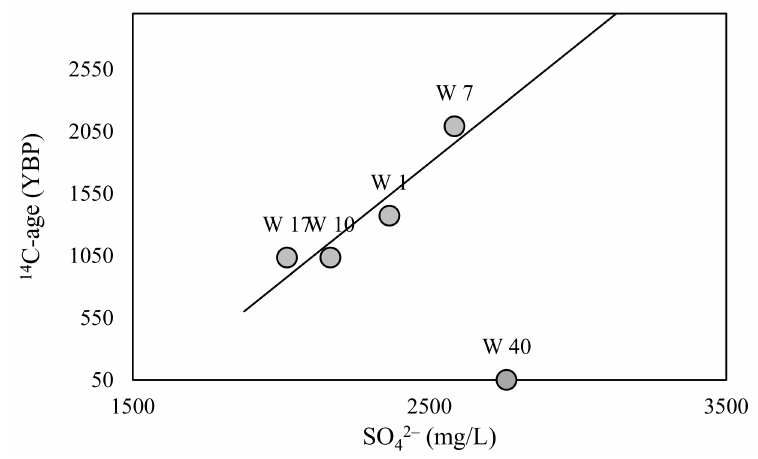
Figure 10. Relationship between 14 C -age of groundwater and SO 42– in the